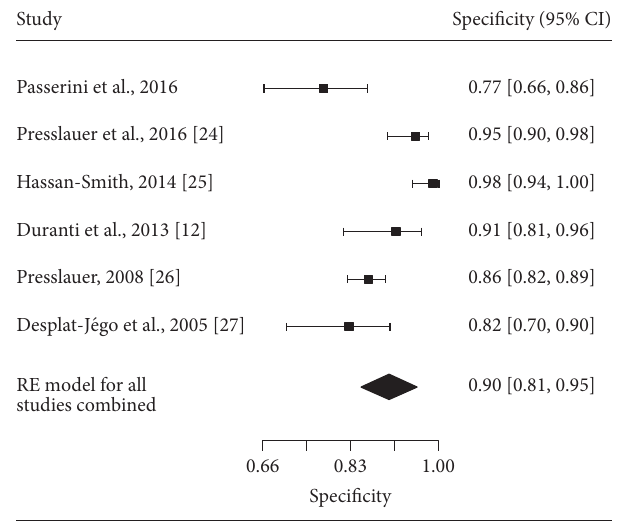
Figure 5: Forest plot of specificities for studies using KFLC index to diagnose MS. Summary estimate for specificity is computed using the approach described by Reitsma et